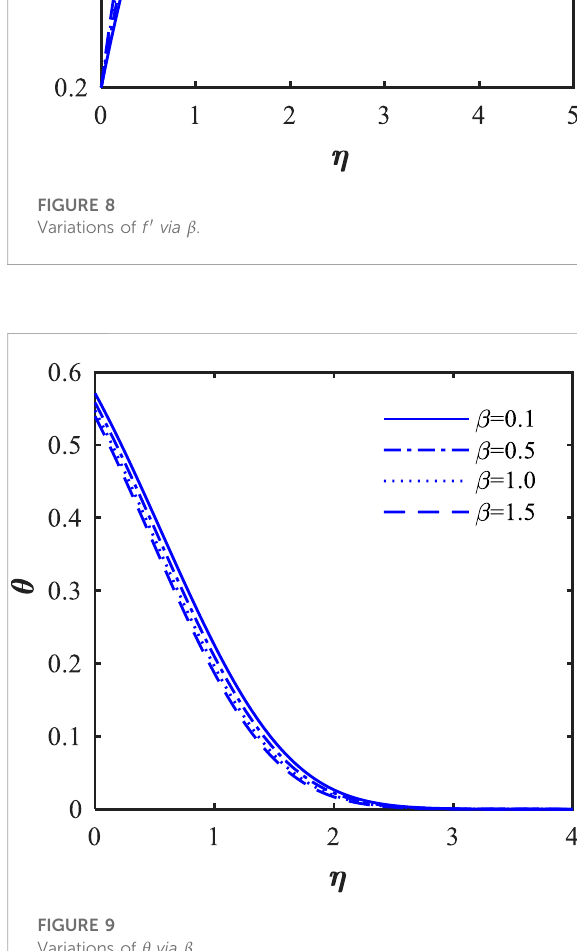
FIGURE 7 Variations of ϕ via λ .